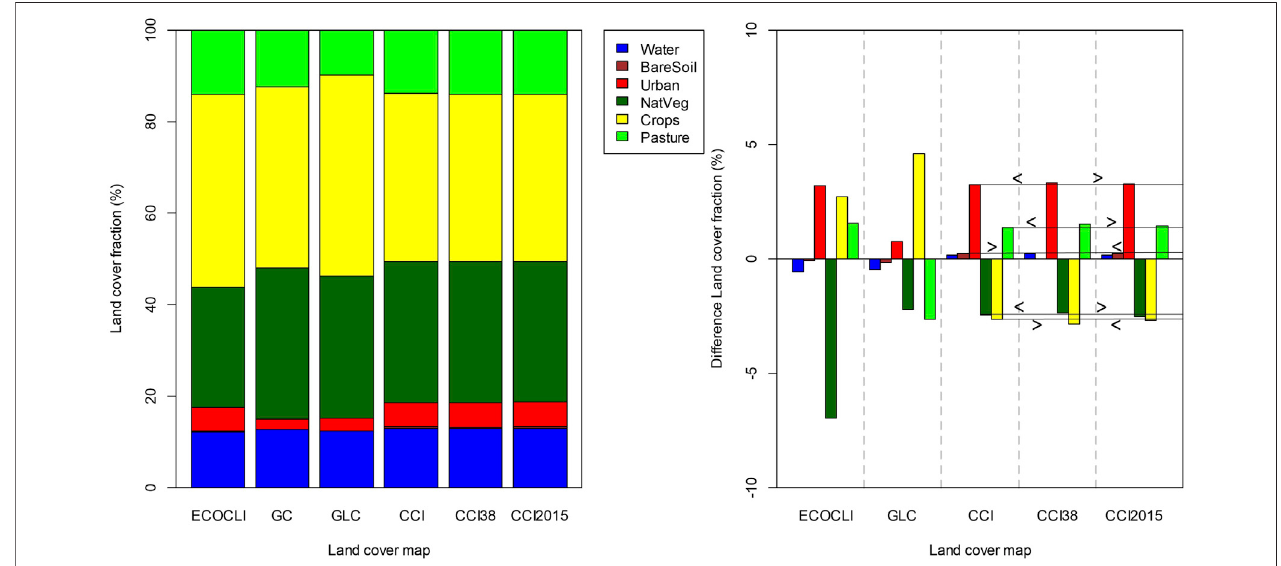
FIGURE 2 | (A) Land cover fraction in percent of water (blue), bare soil (brown), urban (red), natural vegetation (green), crops (yellow), and pasture (light green) of each simulation experiment based onECO, GC, GLC, CCI, CCI38 and CCI 2015. Please see Table 1 for explanationsofthe abbreviations. (B) Differences inlandcover fraction in percent of ECO, GLC, CCI, CCI38, and CCI2015 compared with GC. GC is the control simulation based on GlobCover 2009. Arrows indicate the magnitude difference between the CCI data.